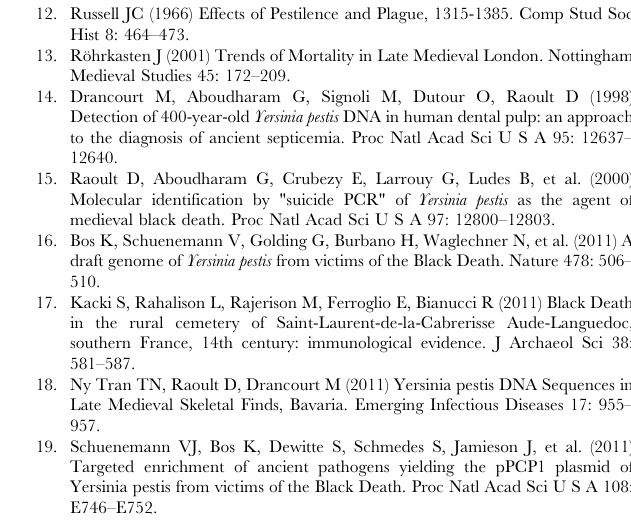
Table S1 Site codes and contexts for all